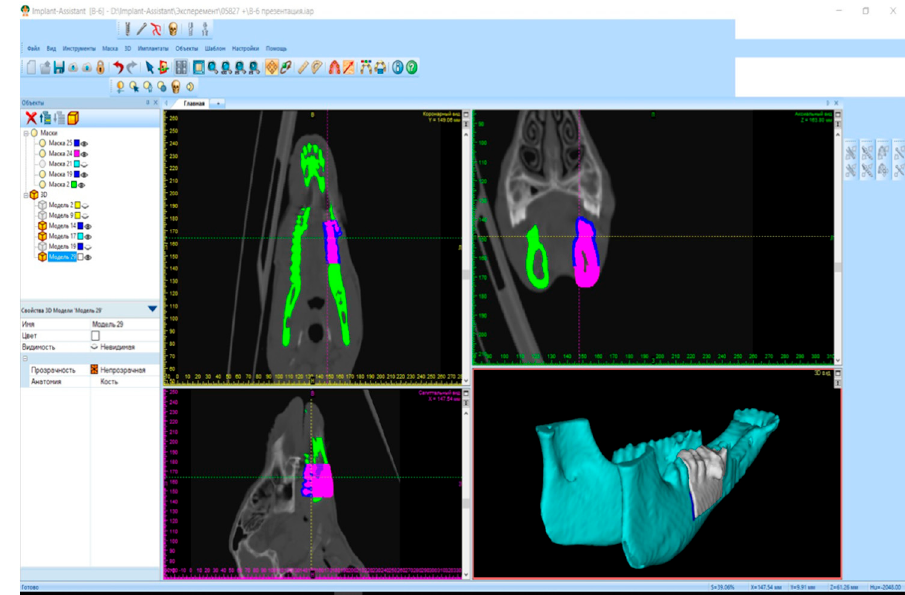
Figure 2. Modeling of titanium implant via “Implant Assistant”.